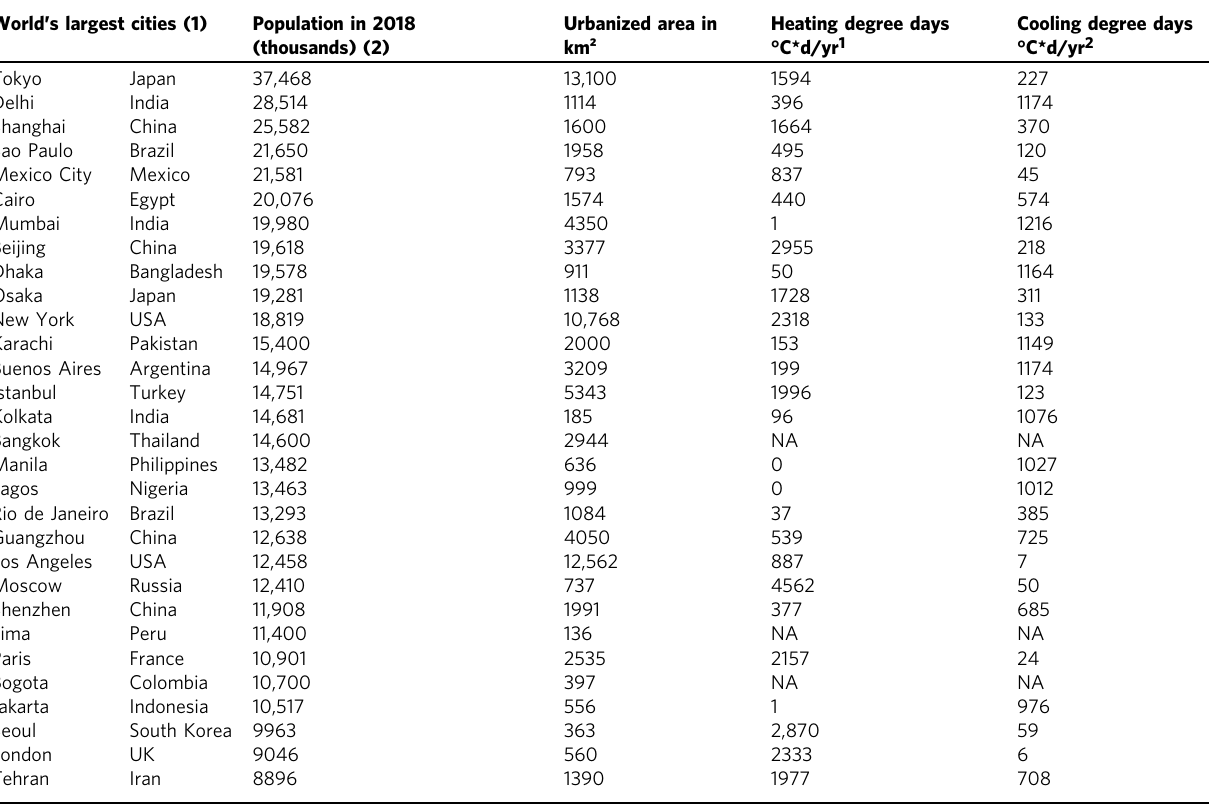
Table 1 Population, urbanized area, and heating and cooling degree days of world ’ s largest cities. World ’ s largest cities